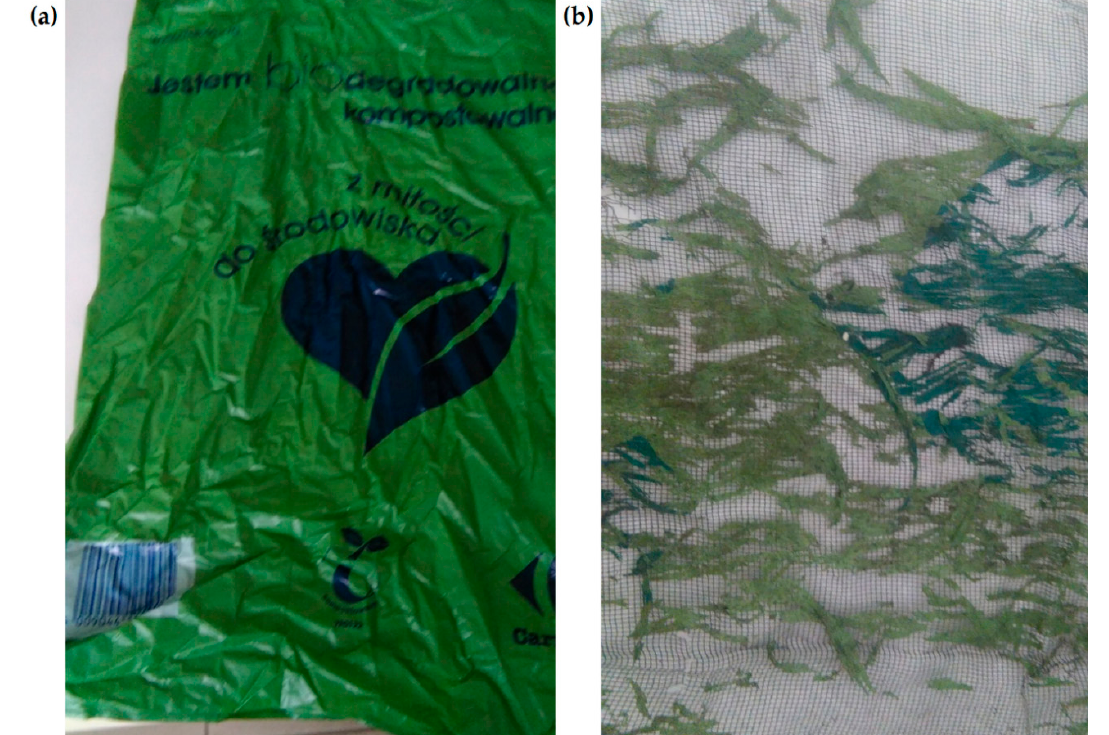
Figure 1. Appearance of sample no. 3: before ( a ) and after the composting process ( b ) [photo F. Markowicz].